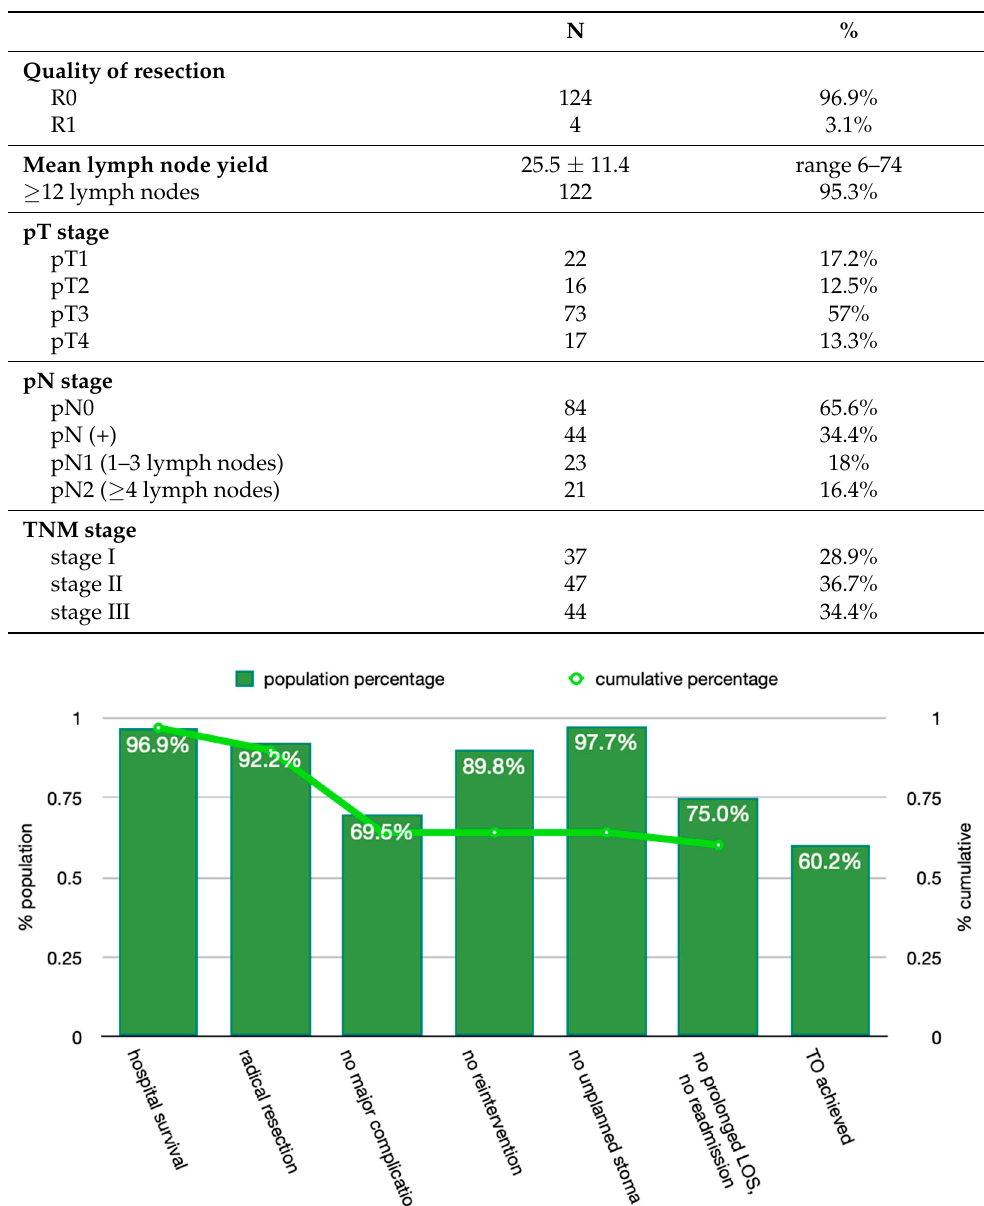
Table 2. Histopathological outcomes.